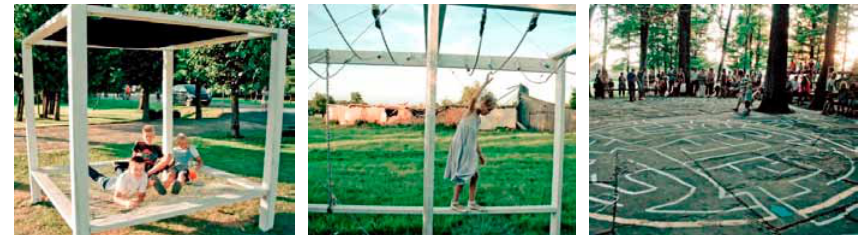
Fig. 2. New public spaces in Teneniai after creative workshops. Two in one: bed/pergola (left); rope obstacle course (centre) and a labyrinth drawing used to renew the paving of the amphitheatre in the park (right). Photo by Tadas